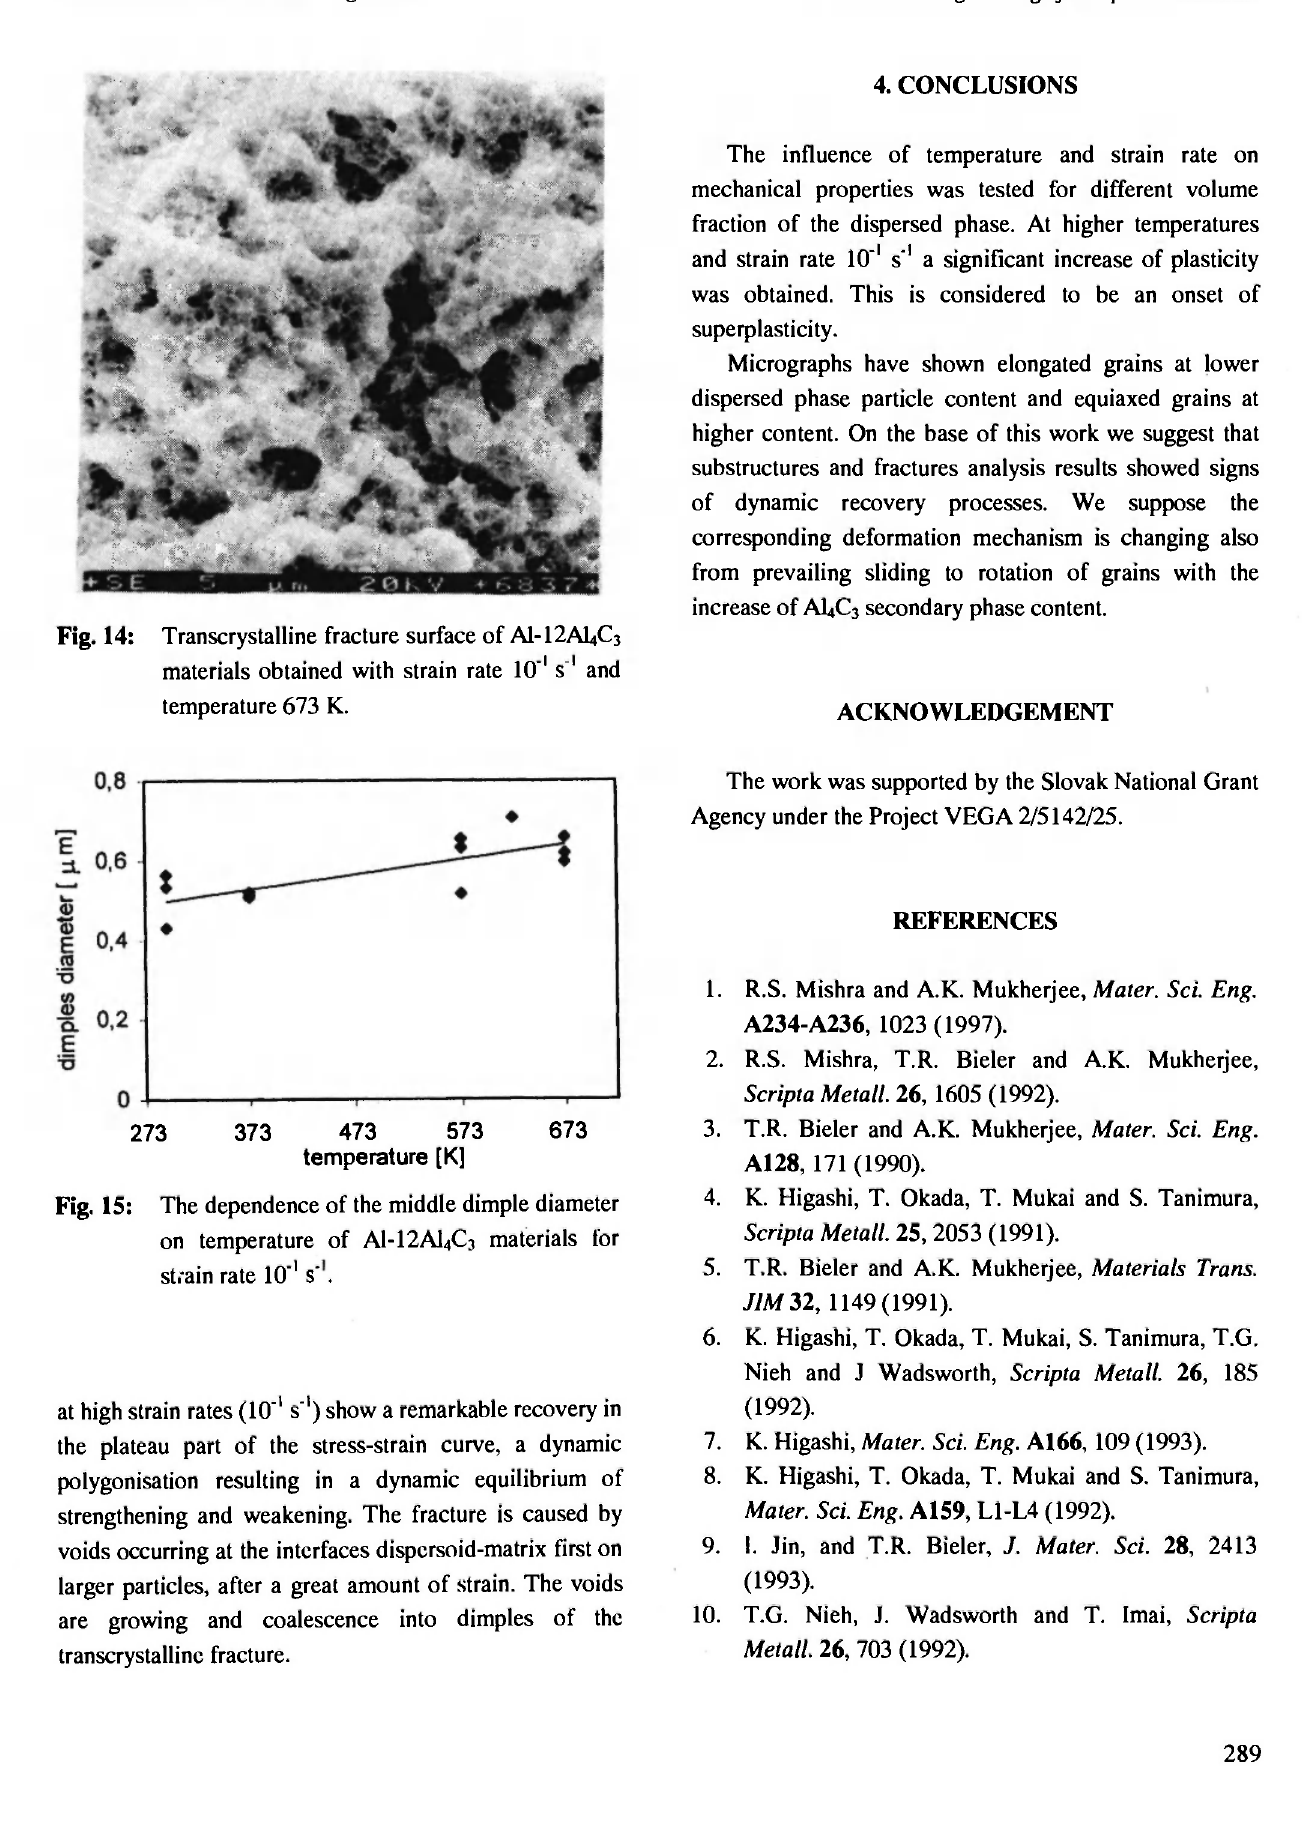
Fig. 15: The dependence of the middle dimple diameter on temperature of Al-12 ALA materials for strain rate 10"' s'.